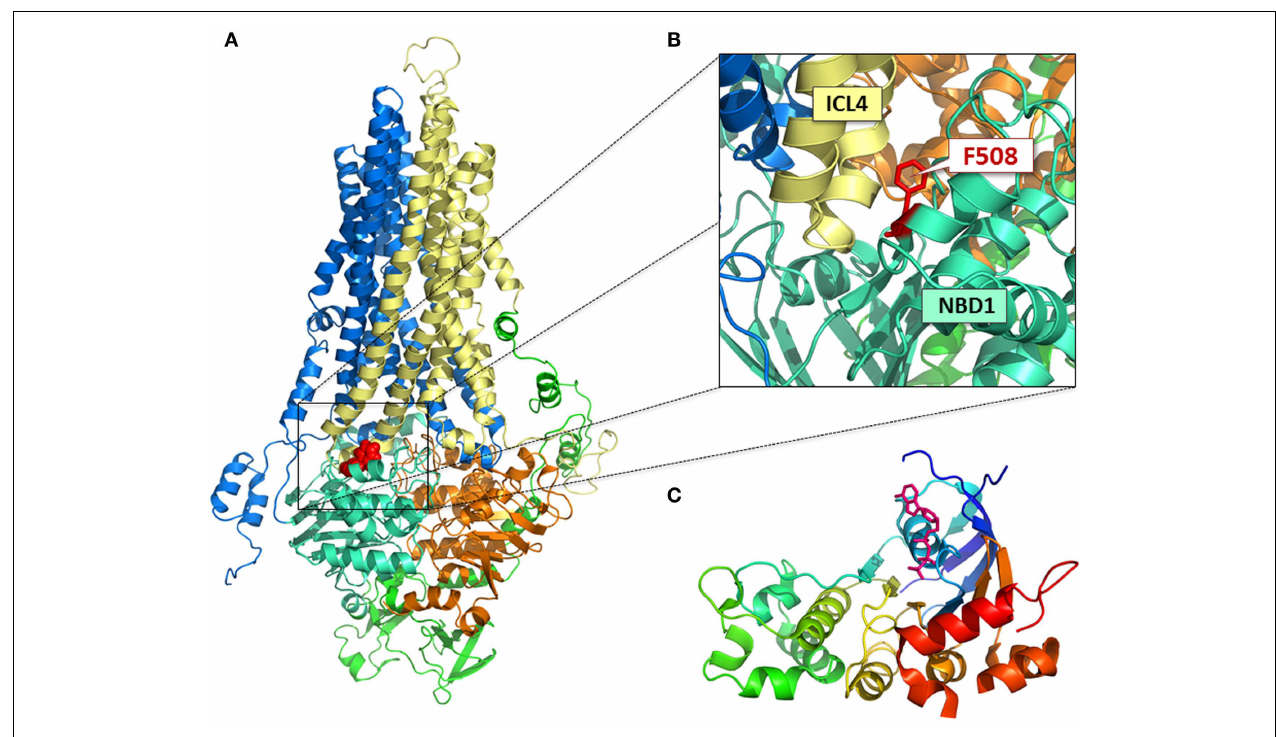
orange; R domain, green; F508, red; (B) position of F508 at the ICL4:NBD1 interface; (C) crystal structure of NBD1 (Lewis et al., 2010); ATP,